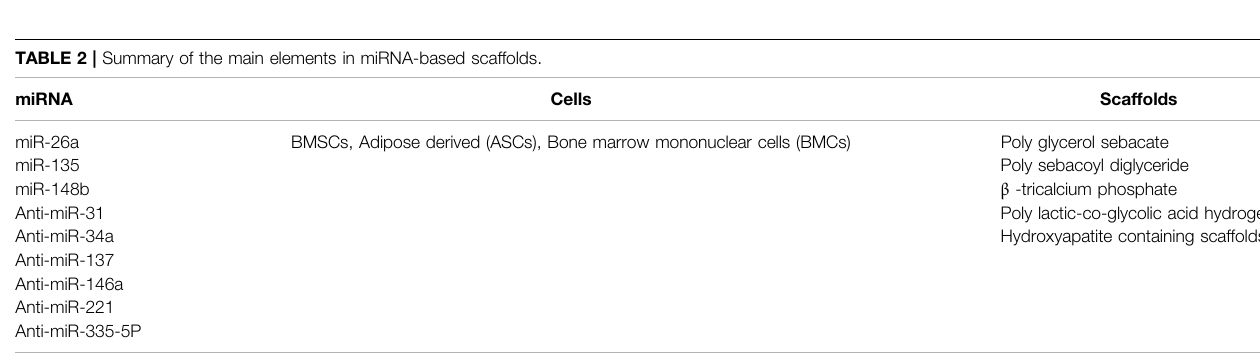
TABLE 2 | Summary of the main elements in miRNA-based scaffolds. miRNA